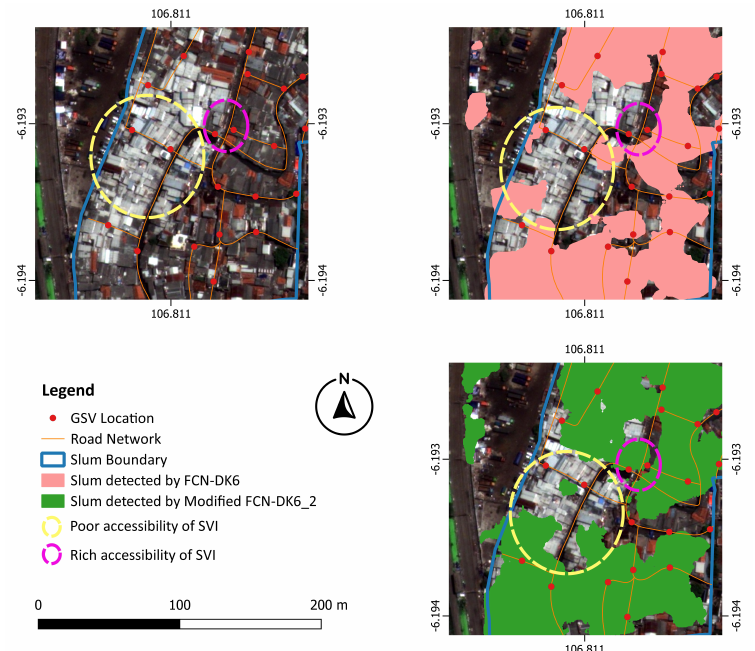
Figure 13. Classification using FCN-DK6 and Modified FCN-DK6_2 for detecting slum areas (area highlighted in yellow, where Modified FCN-DK6_2 and FCN-DK6 performs poorly because access to the GSV location was limited and area highlighted in magenta where Modified FCN-DK6 perform better than FCN-DK6 because access to the GSV location was